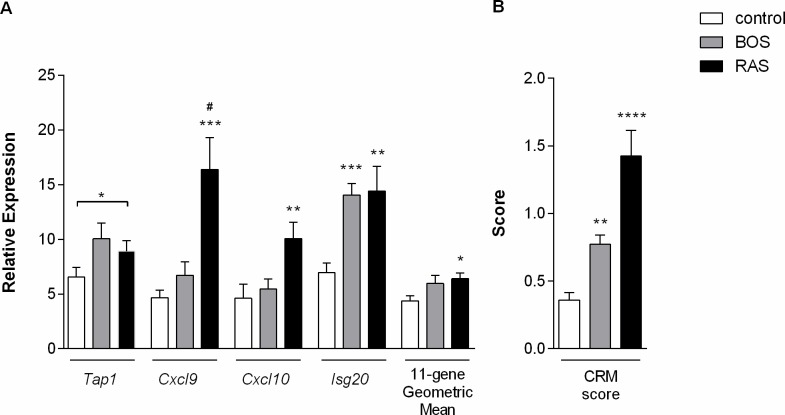
Differentially expressed genes in end-stage tissue.Bar graphs depicting (A) the expression of differentially expressed genes (TAP1, CXCL9, CXCL10, ISG20) and the geometric mean score and (B) the CRM score, based on a 2-gene model, in end-stage tissue of BOS (n = 13), RAS (n = 16) and unused donor lungs (control, n = 15). Values are shown as mean ± SEM. Analysis was done using Kruskal-Wallis one-way ANOVA in combination with Dunn’s post hoc test, not corrected for multiple testing. A p-value <0.05 was considered significant. * p<0.05, ** p<0.01, *** p<0.001, **** p≤0.0001 compared to unused donor lungs; # p<0.05 compared to BOS lungs.